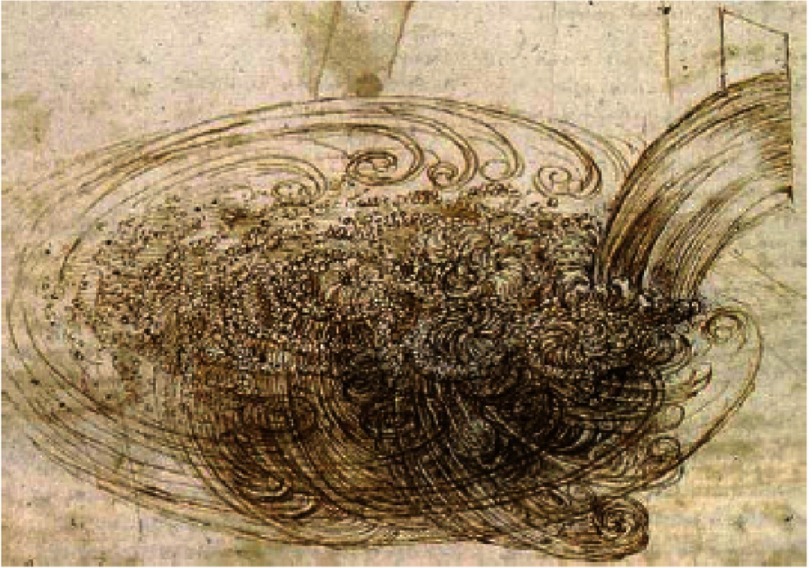
From “Study of water falling into still water”, by da Vinci12 and mentioned in [9].